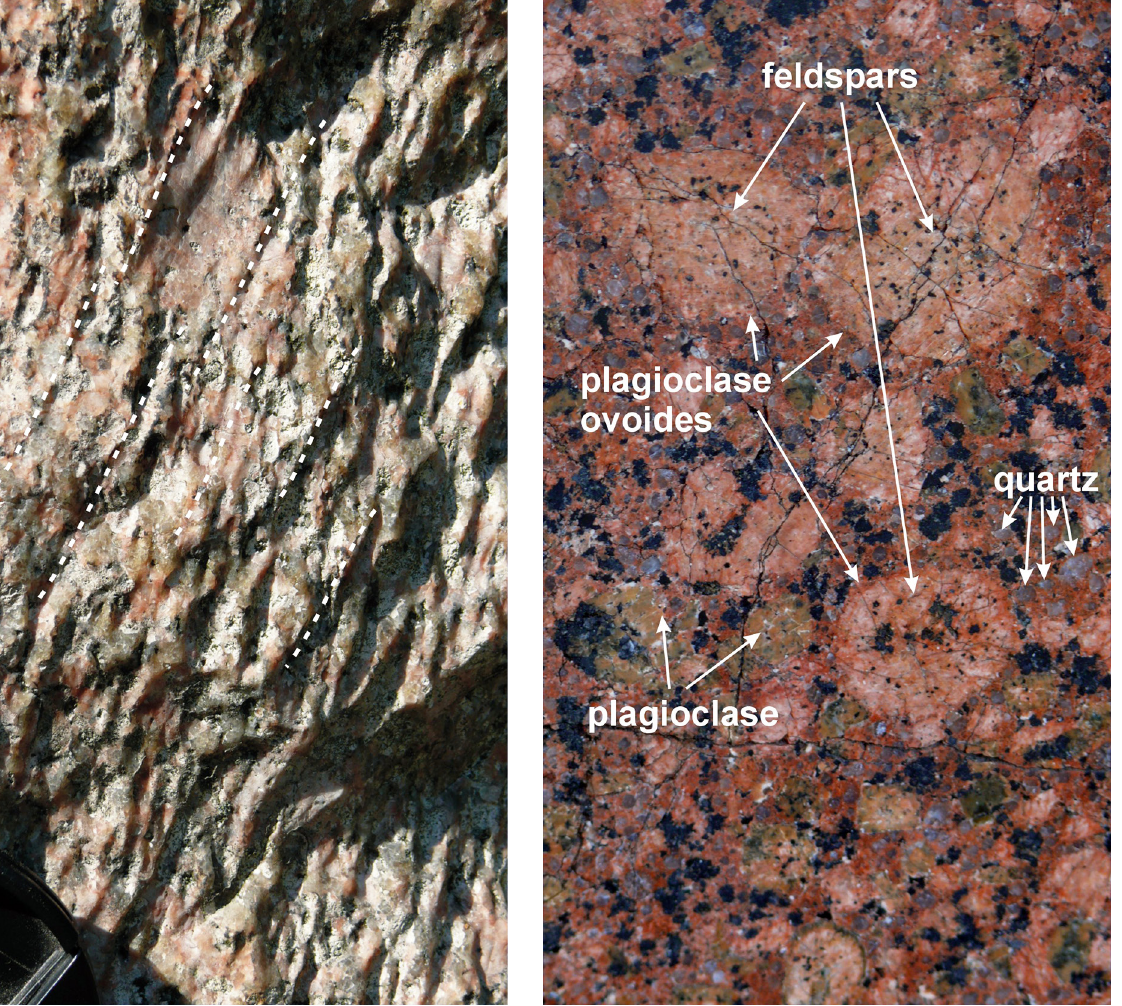
Fig. 9. Sixth largest boulder erratic in Pruszków (at the Bersohn’s Square). Parallel-arranged fine crests and troughs (micro-ribs) are the result of the abrasion – destructive aeolian process affecting the boulder in dry and cold periglacial environment in the foreland of the retreating ice sheet.